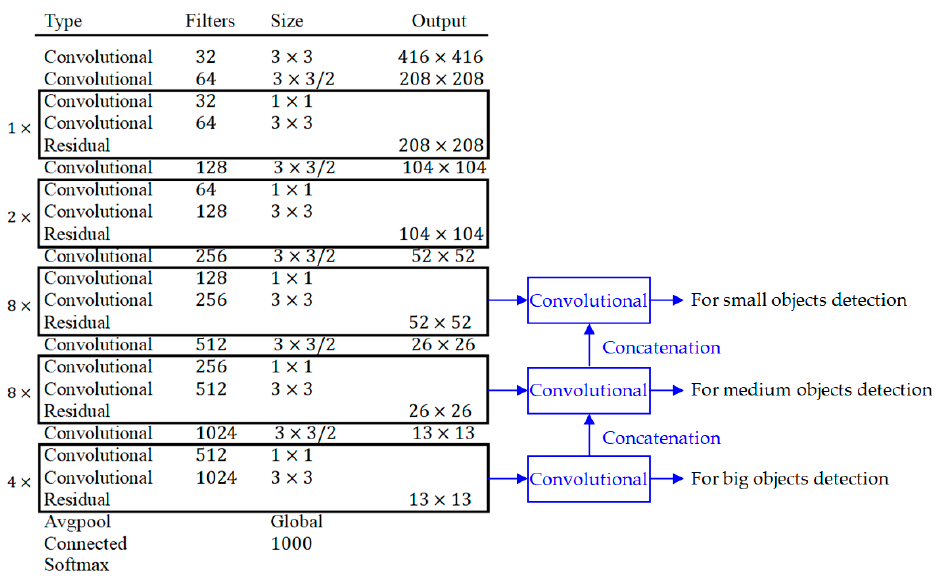
Figure 1. The structure of the DarkNet-53 network.